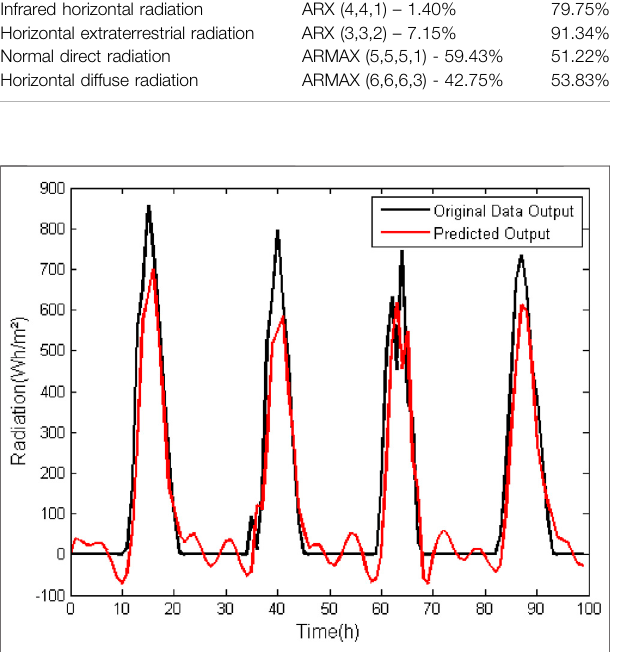
FIGURE 7 | ARMAX model (na = 5, nb = 5, nc = 5. nk = 1) for prediction of Normal Direct Radiation data without suppression of zero.